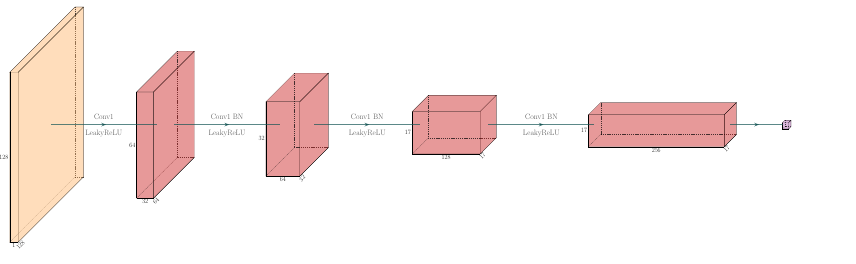
Figure 13. The network structure of discriminator in DCGAN. Conv is the abbreviation of convolu- tional. BN is the abbreviation of batch normalization. LeakyReLu is activation function. The structure of the generator and the discriminator in WGAN-GP is shown in Figures 14 and 15.